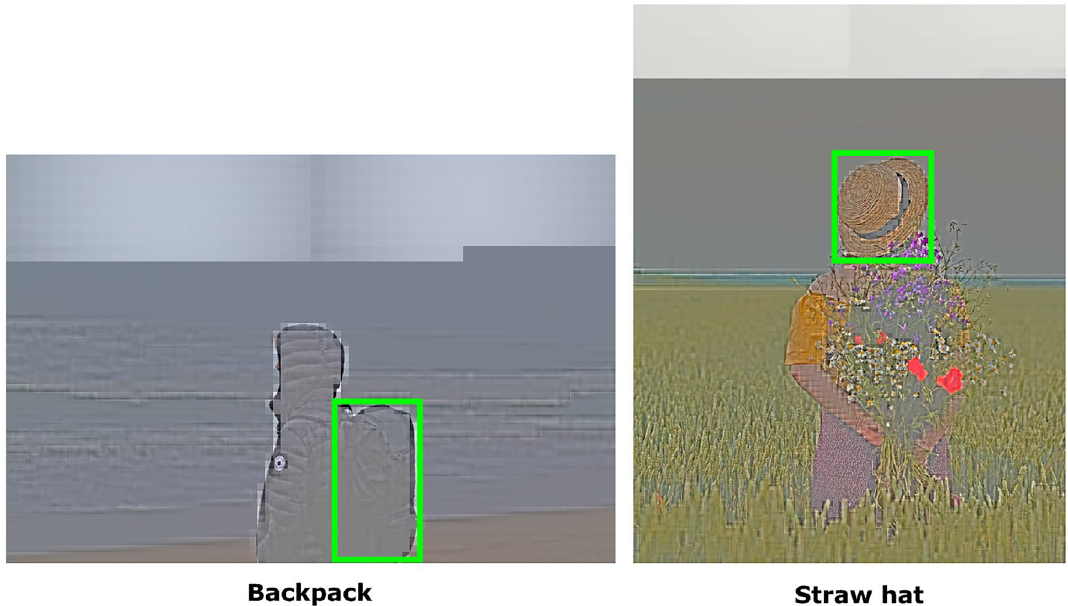
Figure 7. Item bounding-box detection. Localization maps can be easily extended to provide zero-shot bounding boxes for items of interest. Green bounding boxes show the predicted locations for fashion concepts “Backpack” (left) and “Straw hat” (right). Images above are taken from the publicly available Unsplash Lite Dataset 1.2.0: FashionCLIP was tested extensively on ModaNet - please reach out to authors for links to those